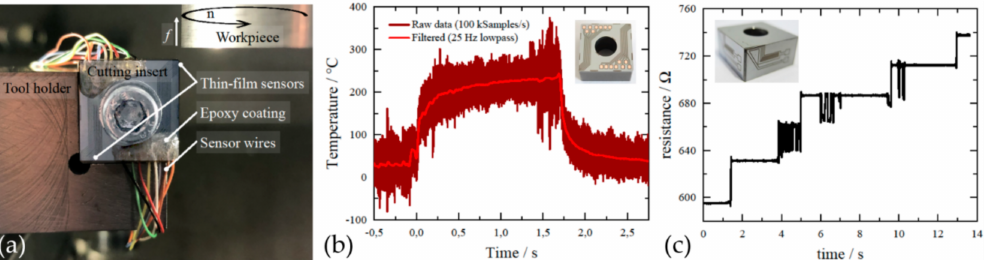
Figure 8. In-line process monitoring with thin film sensors: ( a ) Turning test setup; ( b ) Temperature measurements; ( c ) Principle of wear measurements [46].